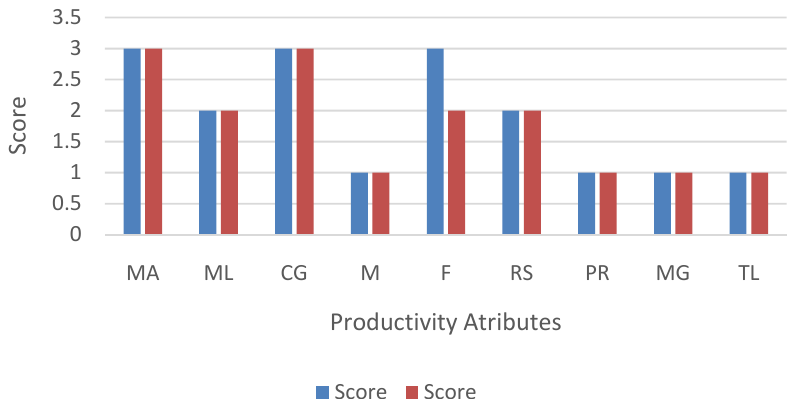
Fig. 3: Score of Plectropomus areolatus and Plectropomus leopardus based on Productivity Attributes. MA, Maximum age; ML, Maximum length; CG, the coefficient of growth; M, Natural mortality; F, Fecundity; RS, Reproductive strategies; PR, The pattern of recruitment; MG, The first measure mature gonads; TL, Trophic